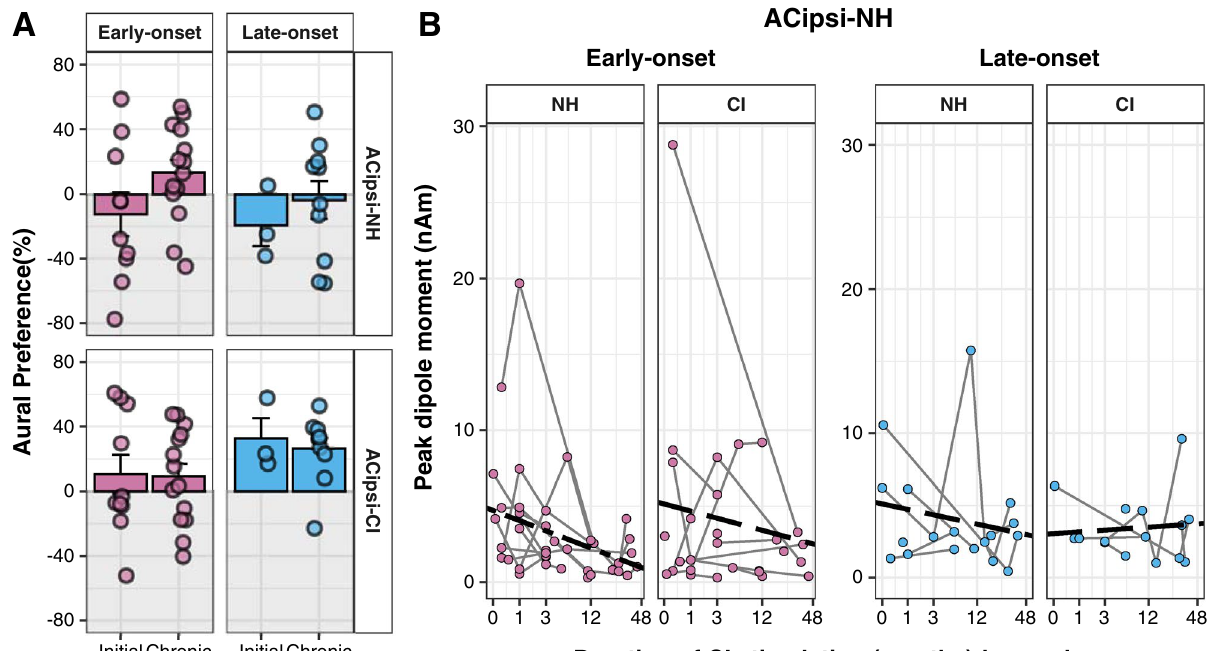
Figure 3. Changes in auditory cortical activity from initial to chronic CI use. (A) Aural preference for each response/child (dots) and mean (± 1 SE) data (bars) quantify the overall change between initial (early-onset: 10 responses in 7 children; late-onset: 3 responses in 3 children) and chronic (early-onset: 14 responses in 11 children; late-onset: 10 responses in 6 children) periods of CI use, indicating, in both groups, a tendency toward normal aural preference in the AC ipsilateral to the NH ear (p = 0.07) and maintained representation of the NH ear in the opposite cortex in both groups (p > 0.05). (B) Dipole changes with CI use are shown for each child, revealing a time-dependent reduction of responses stimulated by the NH ear in the ipsilateral cortex in the early-onset group only (p = 0.06). ACipsi-CI: Auditory cortex ipsilateral to the implanted ear; ACipsi-NH: Auditory cortex ipsilateral to the NH